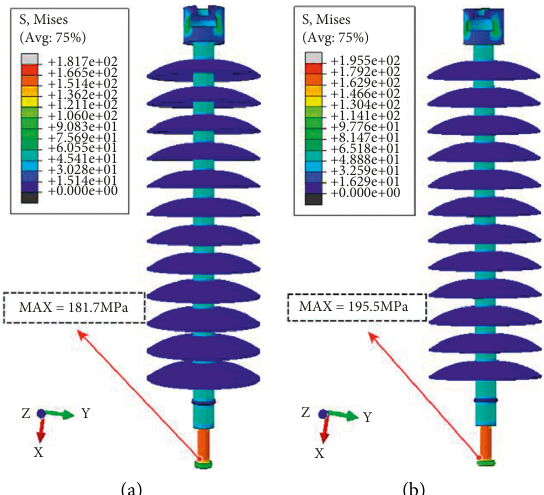
Figure 37: Stress cloud picture of insulator string: (a) connected with the ice-shedding conductor; (b) connected with the iced conductor.